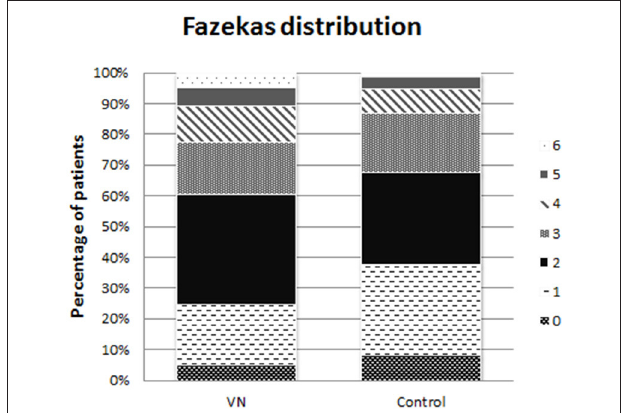
FIGURE 1 | Fazekas scale for MRI imaging. The figure displays hyperintensities in the deep white matter (upper row) and periventricular (lower